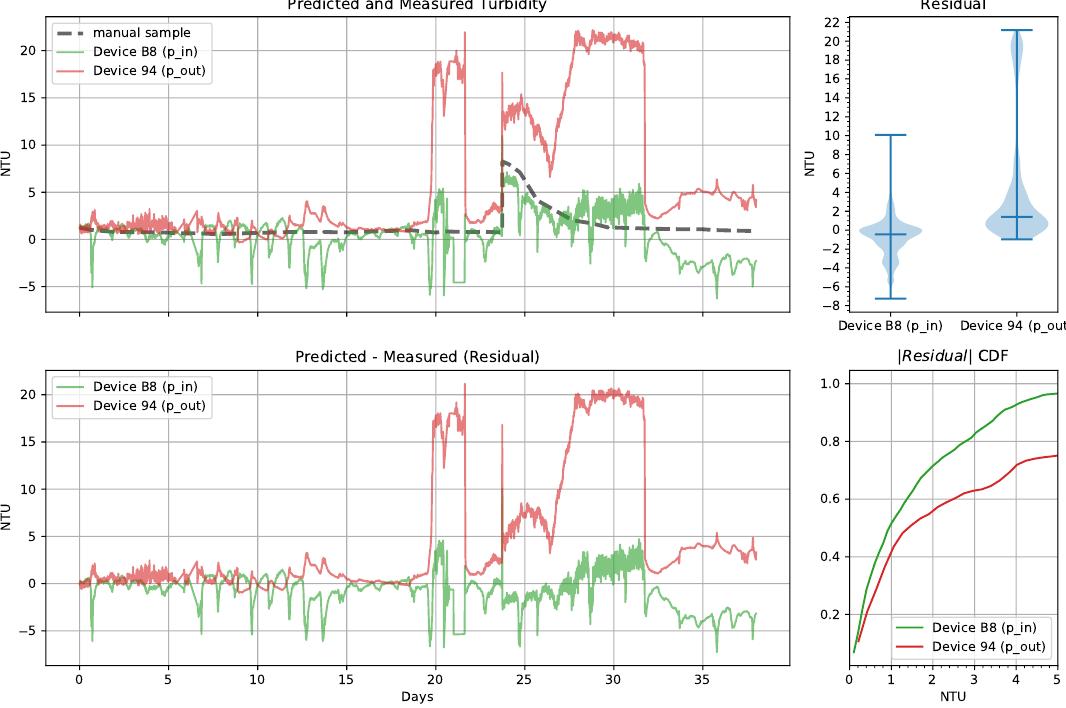
Figure 14. Pumped tank low-cost continuous turbidity monitor predictions from the pump inlet (p_in) and outlet (p_out) and manual measurements from a hand-held turbidimeter showing all collected data (days 0 through